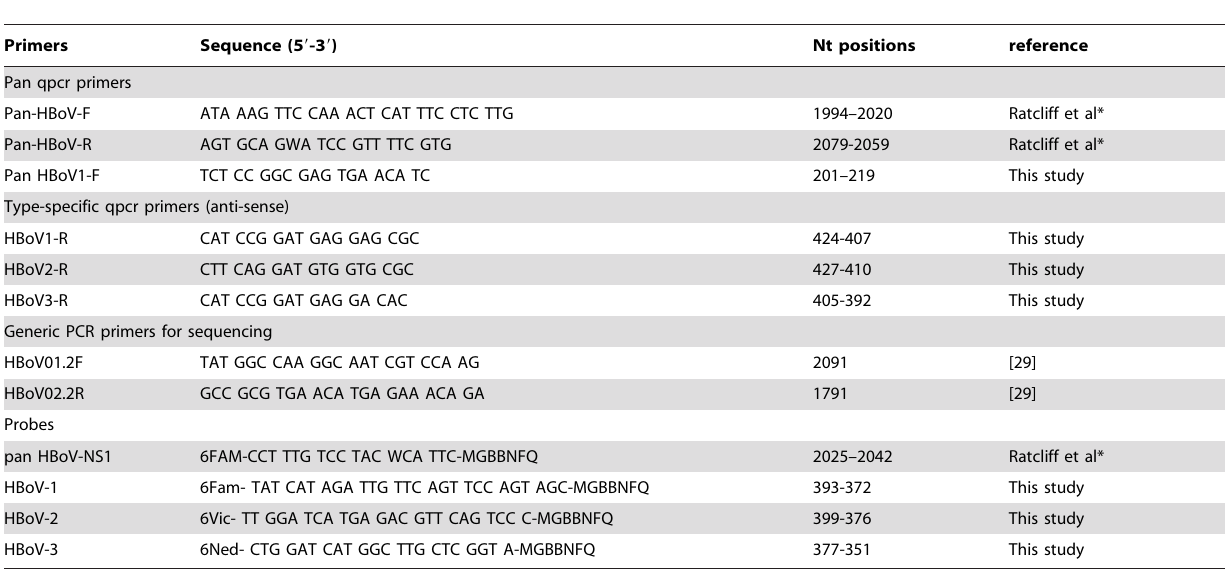
Table 1. HBoV-specific oligonucleotide primers and probes (all located at the NS gene).